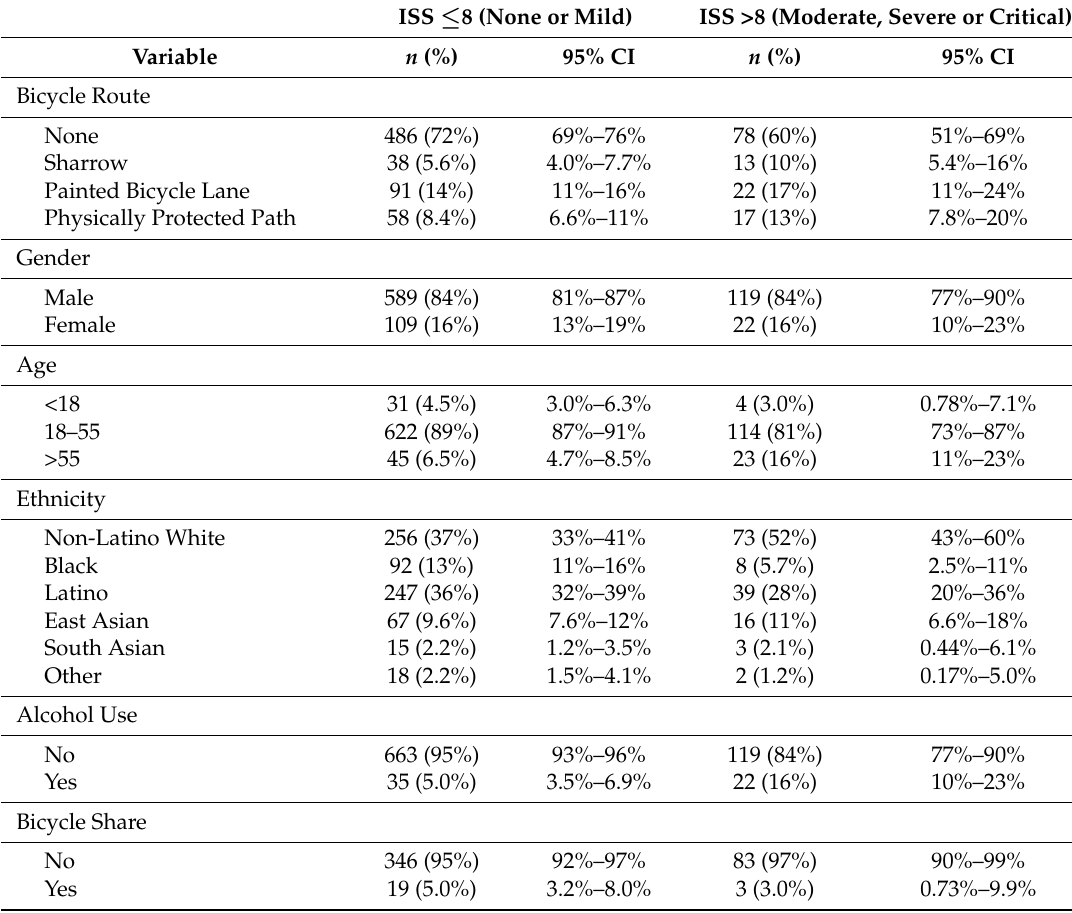
Table 1. Stratified analysis of behavior and environment variables by injury severity score